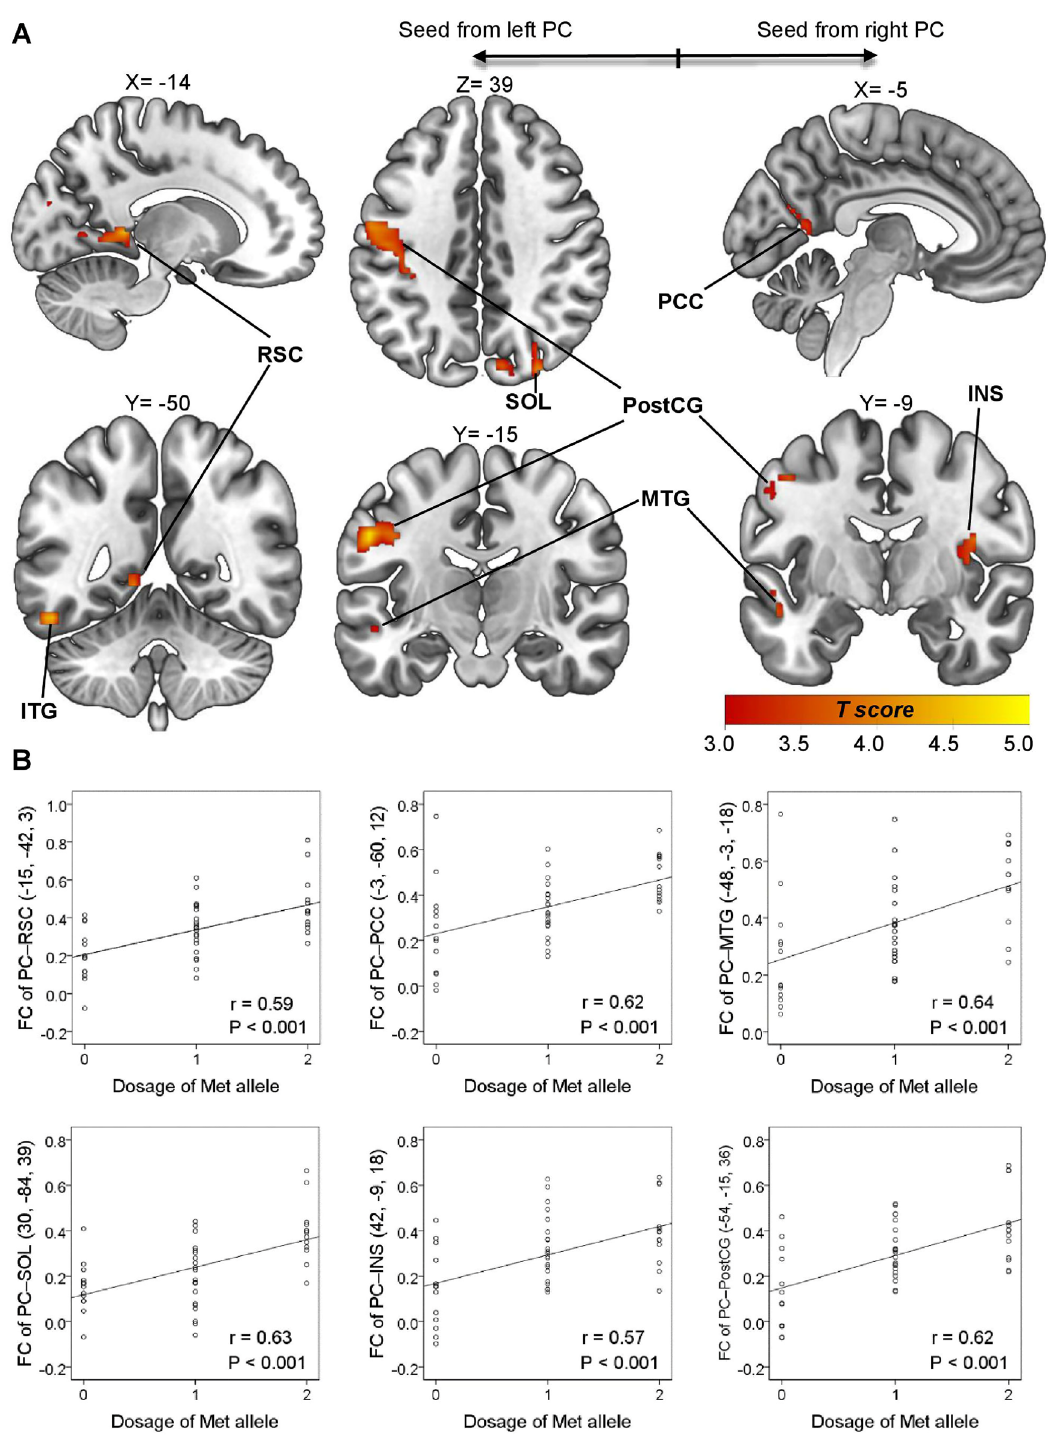
Figure 2. Representations of BDNF gene-informed piriform cortex (PC)-seeded olfactory network (olfaction cohort, n = 47). ( A ) The between-group comparison of olfactory networks in the Met/Met and Val/Val group exhibited stronger links to the semantic (middle/inferior temporal gyrus, MTG/ITG) and autobiographical (retrosplenial cortex, RSC; posterior cingulate cortex, PCC) memory areas, visual cortex (superior occipital lobule, SOL), gustatory area (insula, INS) and somatosensory area (postcentral gyrus, PostCG). ( B ) Met-allele dosage effect on the PC-seeded functional connectivity (FC). Note that in the linear regression model, Met/Met was defined as “2”, Val/Met as “1”, and Val/Val as “0”. The peak coordinates and the linear regression results for the Met-allele dosage effect can be found in Table